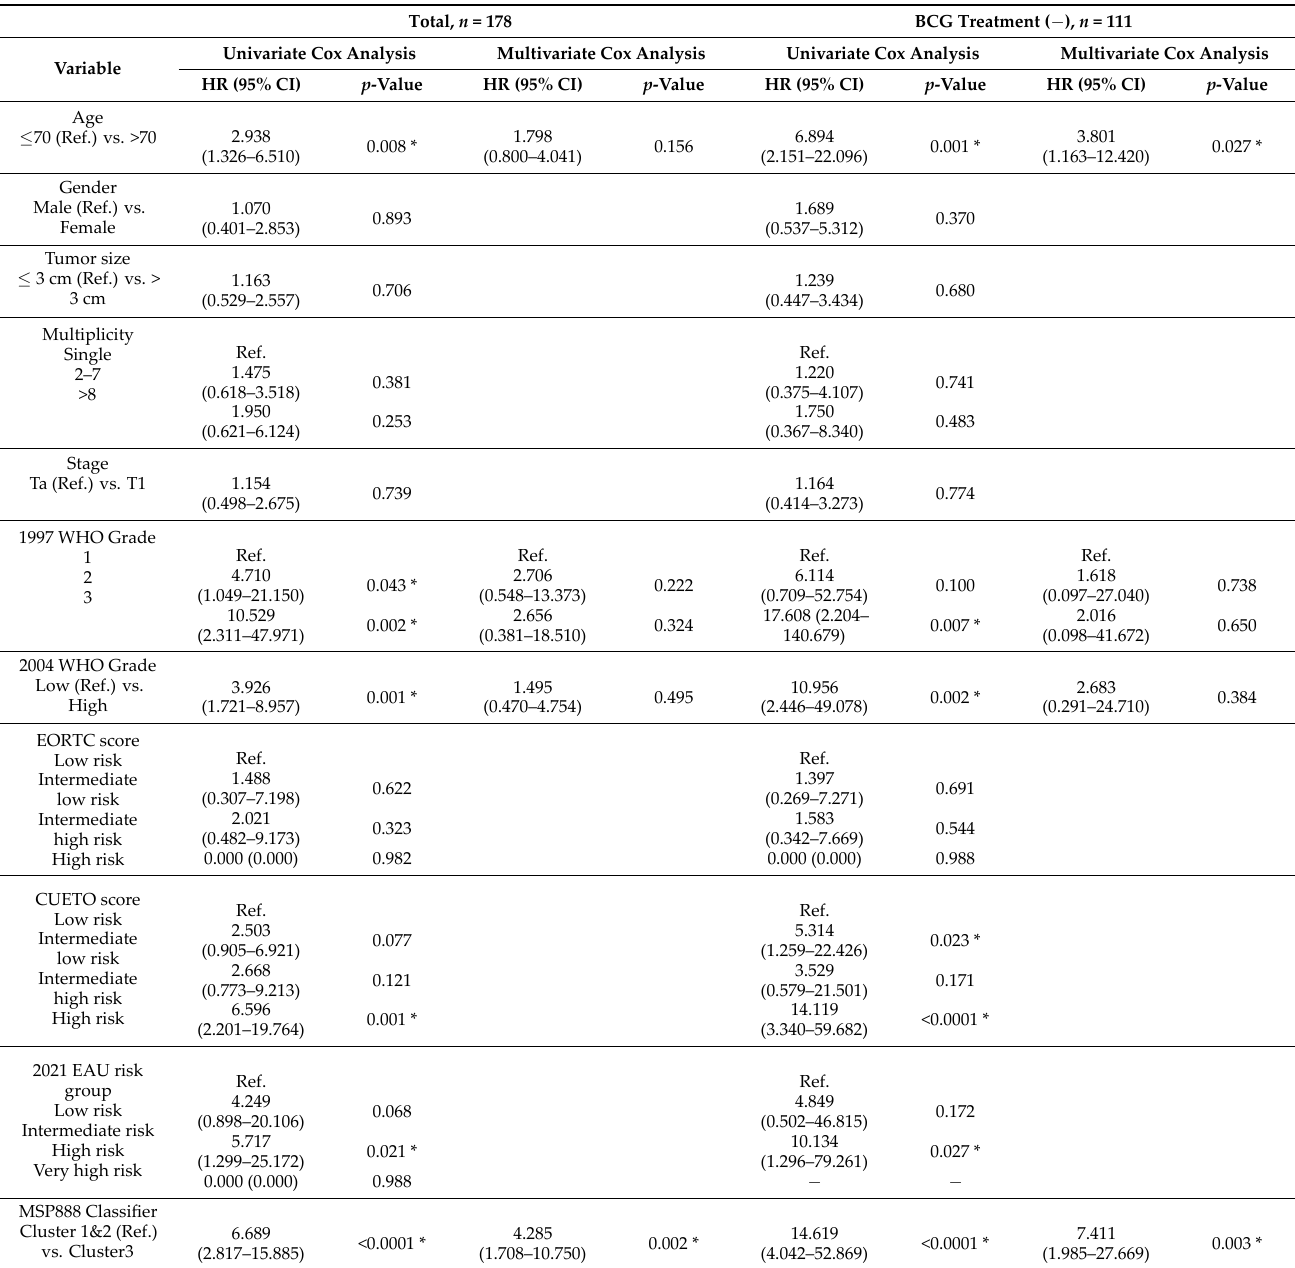
Table 3. Univariate and multivariate Cox regression analyses to predict progression of NMIBC pa‑ tients in the CBNUH